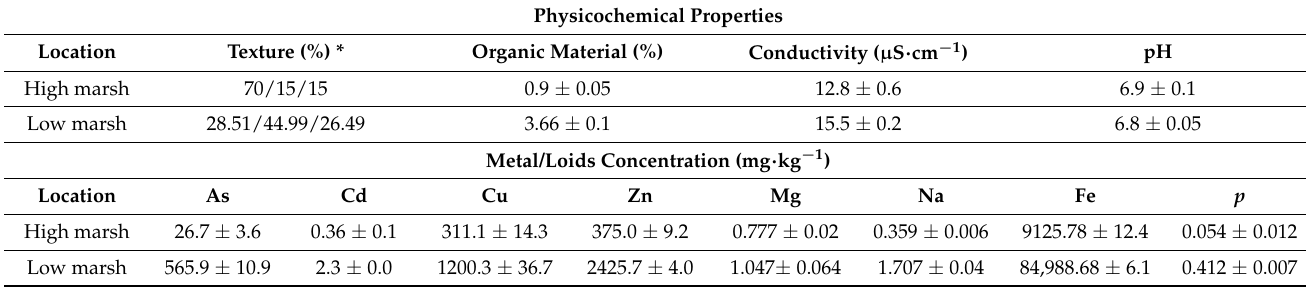
Table 3. Physicochemical properties and micronutrient concentrations of soil from the Rio Odiel estuary.